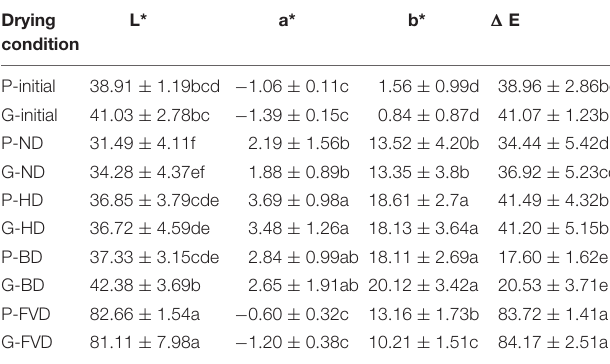
TABLE 3 | Color analysis of asparagus treated with different drying methods.